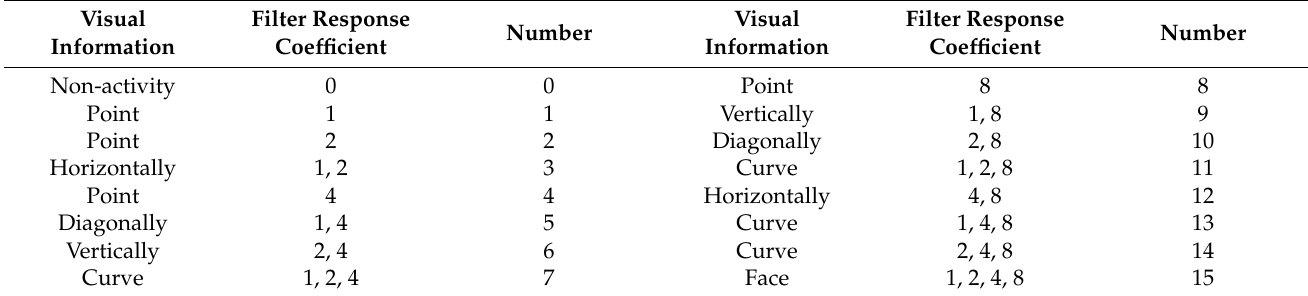
Figure 11. Normalization operation using detection filter. Table 1. Types and values of the line segments for the 3 × 3 filter.